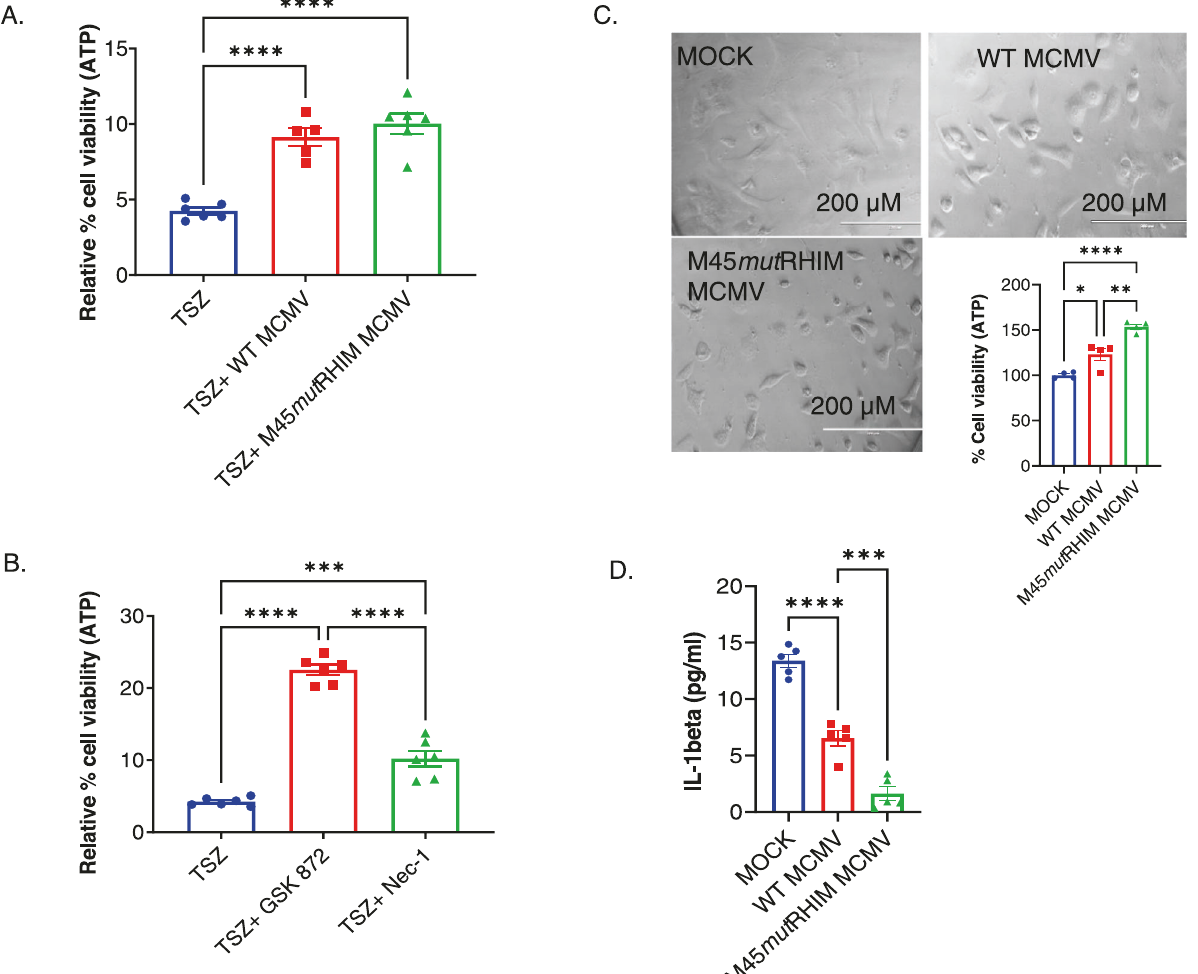
Fig. 1 MCMV infection prevents necroptosis in cardiomyocytes independent of ZBP1-RIPK3 pathway by suppressing upstream in fl ammation. A Viability of neonatal cardiomyocytes obtained from C57BL/6 J mice were treated with necroptosis inducing agents TSZ in the presence and absence of MCMV (WT or M45 mut RHIM mutant MCMV) infection. B Viability of neonatal cardiomyocytes treated with TSZ in the presence and absence of necroptosis inhibitor GSK872 (RIPK3 inhibitor) or Nec-1 (RIPK1 inhibitor). C Phase-contrast image and viability assessed by ATP levels in WT and M45 mut RHIM mutant CMV-infected of neonatal cardiomyocytes. D In fl ammatory cytokine Interleukin-1 beta (IL-1 β ) was measured in the culture medium of neonatal cardiomyocytes infected with WT or M45 mut RHIM mutant MCMV. WT CMV = K-181- bac. One-way ANOVA followed by Tukey ’ s multiple comparison test was performed. Values are mean ± SE. Each point represents one sample. n = 4 – 6. *** P < 0.001; **** P < 0.0001. Protein Kinase-3 (RIPK3) with adaptor proteins, such as RIPK1, Z-DNA binding protein-1 (ZBP1, also termed DAI) - a virus-induced nucleic acid sensor protein, and TIR-domain-containing adaptor- inducing interferon- β (TRIF), which is involved in response to activation of Toll-Like Receptors (TLRs) [27 – 29]. These interactions occur through a small protein-protein interaction motif known as RIP homotypic interaction motif (RHIM). Activation of different receptors and interaction of adapter proteins with RIPK3 lead to RIPK3 phosphorylation and activation [30]. The activated RIPK3 phosphorylates Mixed Lineage Kinase-Like (MLKL), a downstream effector molecule in the necroptosis pathway, which undergoes oligomerization and subsequently cell membrane insertion lead- ing to cell swelling, disruption of plasma membrane integrity, and cell lysis [31, 32]. MCMV encodes the M45 gene, which is the fi rst identi fi ed Viral Inhibitor of Receptor- interacting protein Activation (vIRA) that inhibits necroptosis [29]. M45 contains a RHIM and inhibits RIPK3 through RHIM-dependent interaction during infection to suppress the ZBP1 ‐ RIPK3 ‐ dependent necroptosis [33]. Increased necroptosis